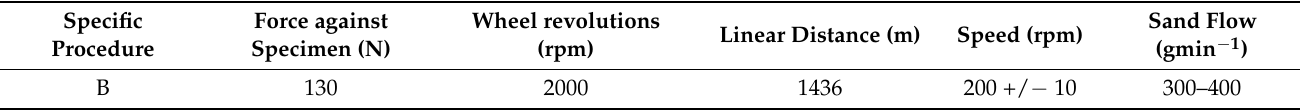
Table 5. Abrasion resistance test conditions according to ASTM G65 standard.